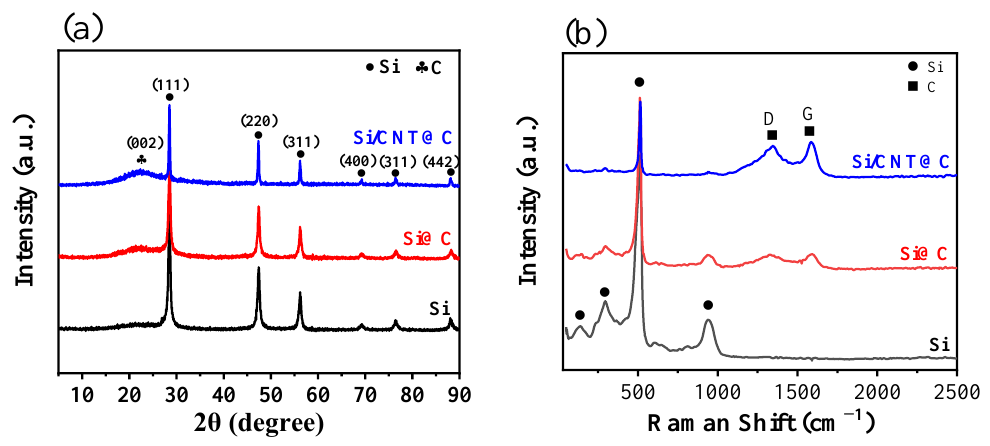
Figure 2. ( a ) XRD patterns and ( b ) Raman spectra of the samples.